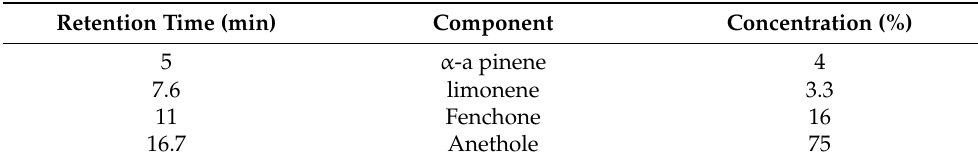
Table 2. Major component in fennel essential